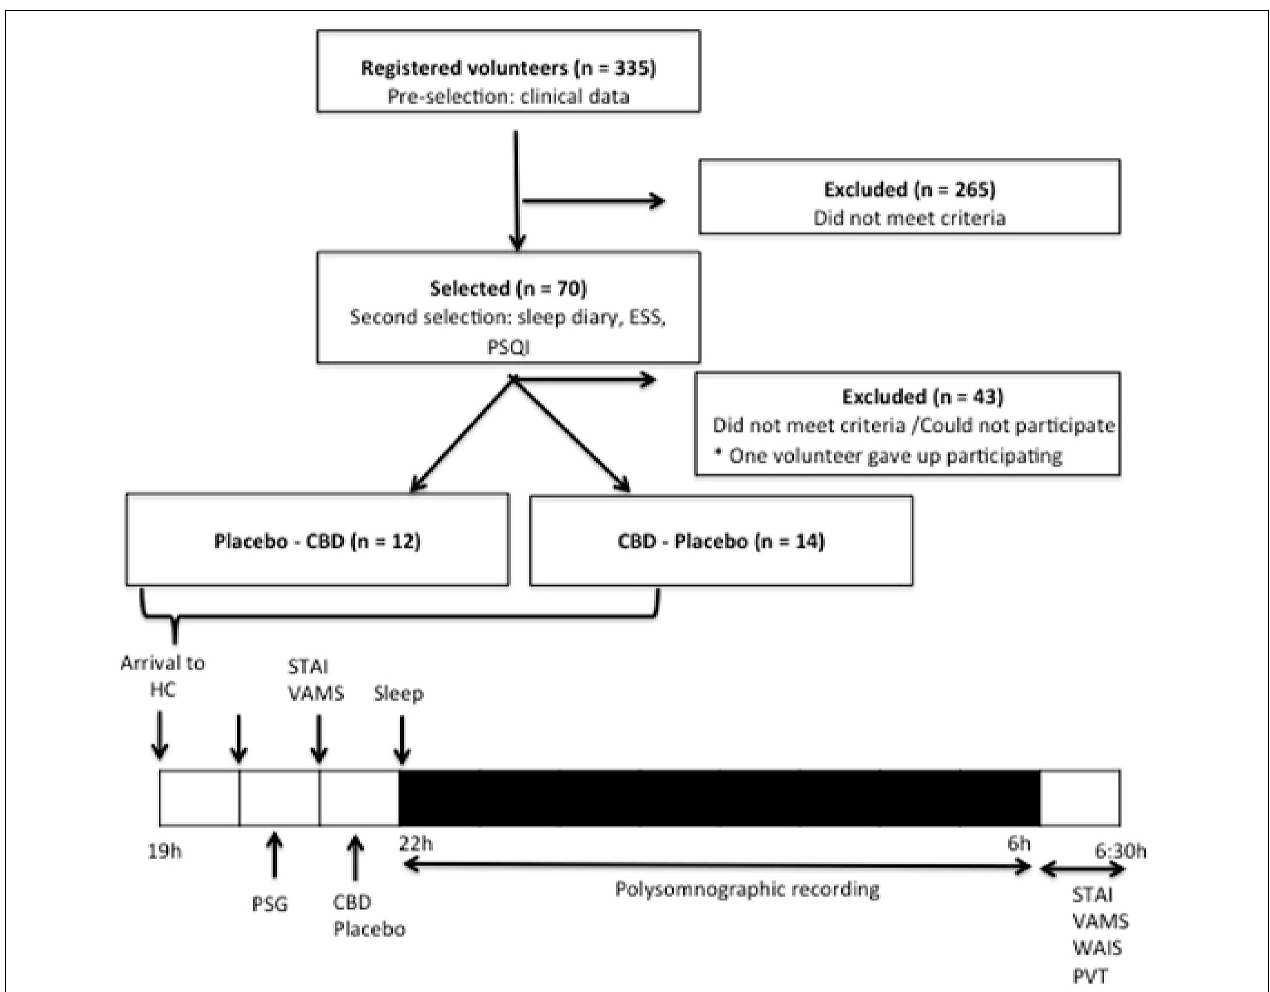
FIGURE 1 | Schematic representation of the participants selection and of the protocol – this was a four period crossover study. CBD, cannabidiol; ESS, Epworth Sleepiness Scale; PSQI, Pittsburgh Sleep Quality Index; PSG, polysomnography; PVT, Psychomotor Vigilance Test; STAI, State-Trait Anxiety Inventory; TCLE, written informed consent form; VAMS, Visual Analog Mood Scale; WAIS, Wechsler Adult Intelligence